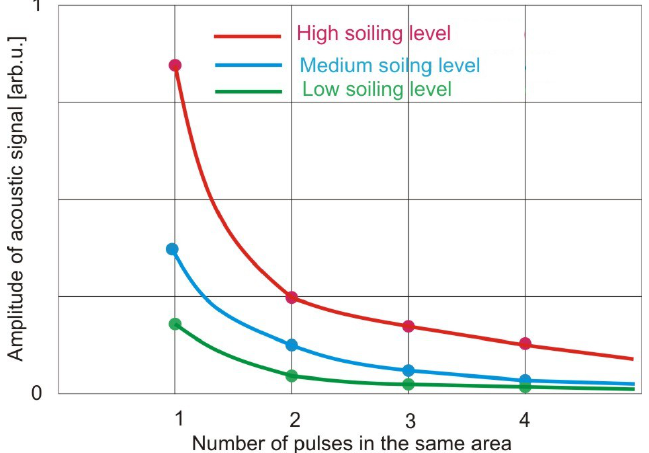
Figure 46. Amplitude of acoustic signal for three different soiling levels as indicated, as a function of the number of successive